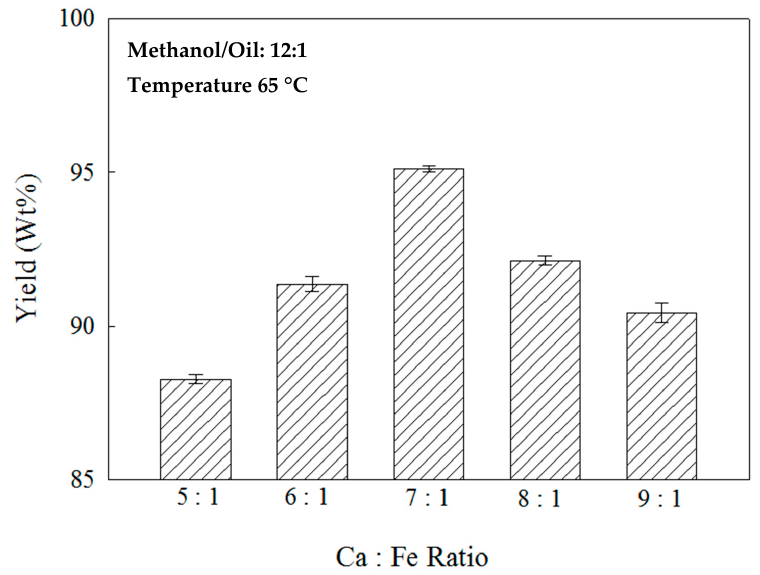
Figure 4. Effects of the catalyst Ca:Fe ratio on the yield with a methanol/oil molar ratio of 12:1.